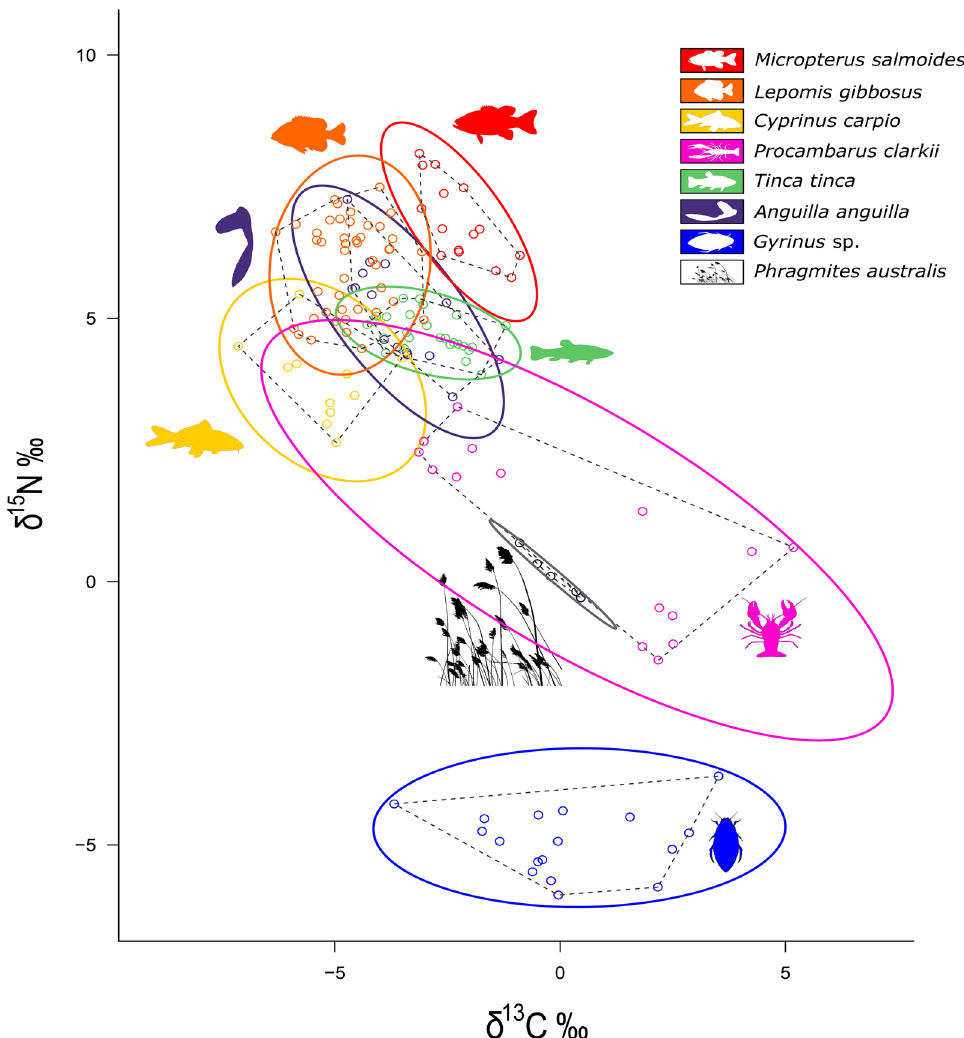
Figure 1.. Isotopic niches of non-native species present in Arreo Lake and the as present assumed native T. tinca and Gyrinus sp.. Solid line = 95% Standard Ellipse Area (SEAb); dashed line = Total Hull Area (TA); blue: Gyrinus sp.; brown: Phragmites australis ; pink: Procambarus clarkii ; yellow: Cyprinus carpio ; orange: Lepomis gibbosus ; green: Tinca tinca ; purple: Anguilla anguilla ; red: Micropterus salmoides